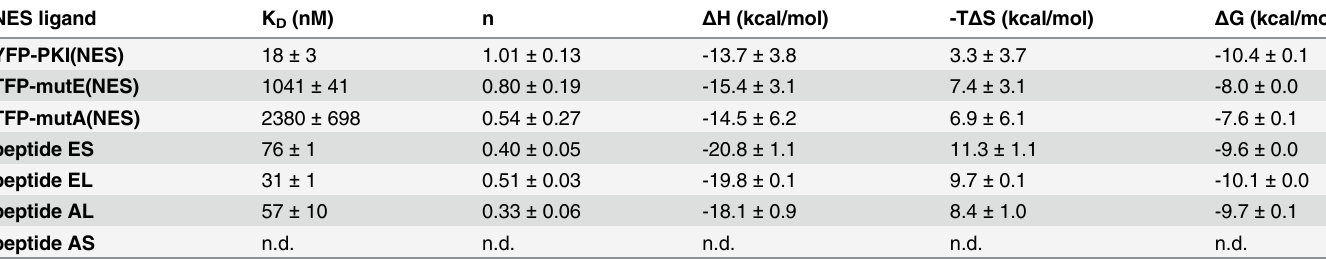
Table 2. Thermodynamic parameters of CRM1 HA / NES interactions determined by